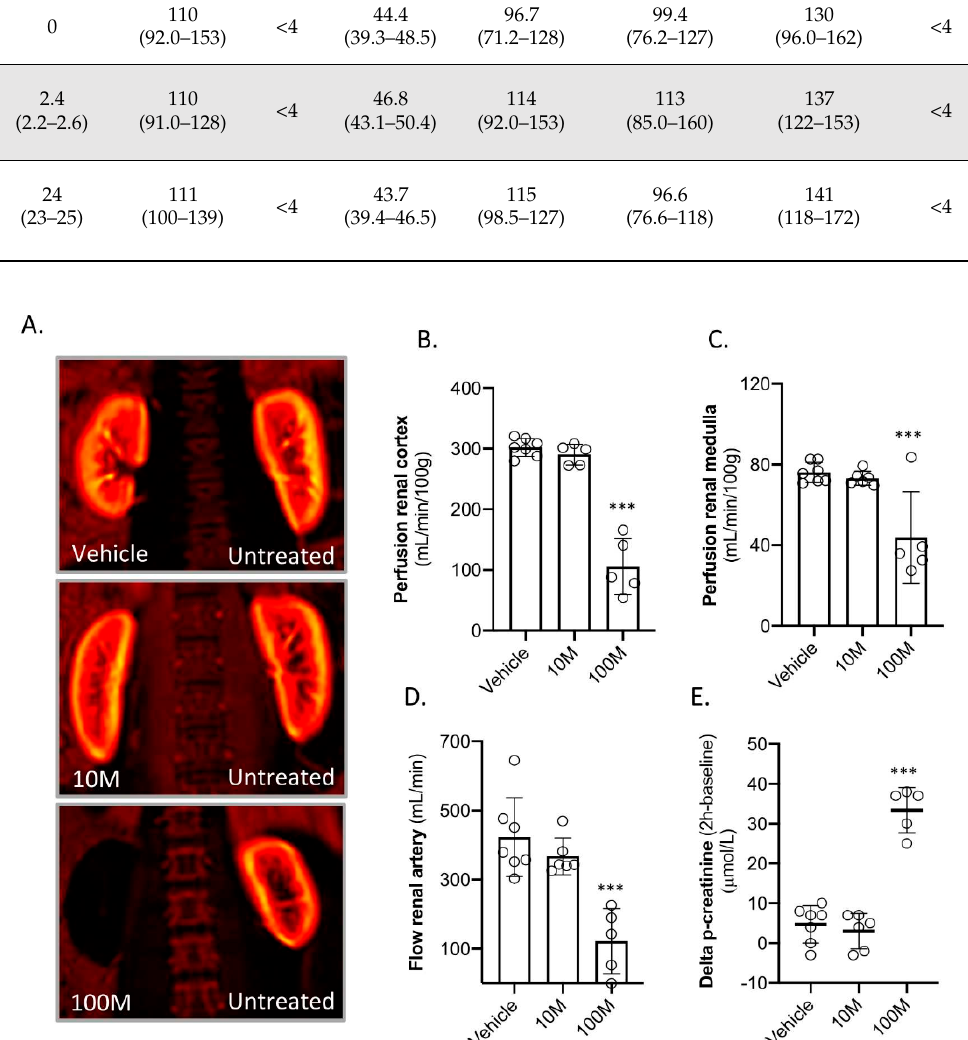
Figure 1. Kidney haemodynamics and plasma creatinine levels directly after intra-renal arterial MSC administration (right kidney). The animals were treated with vehicle (PBS; n = 7), ten